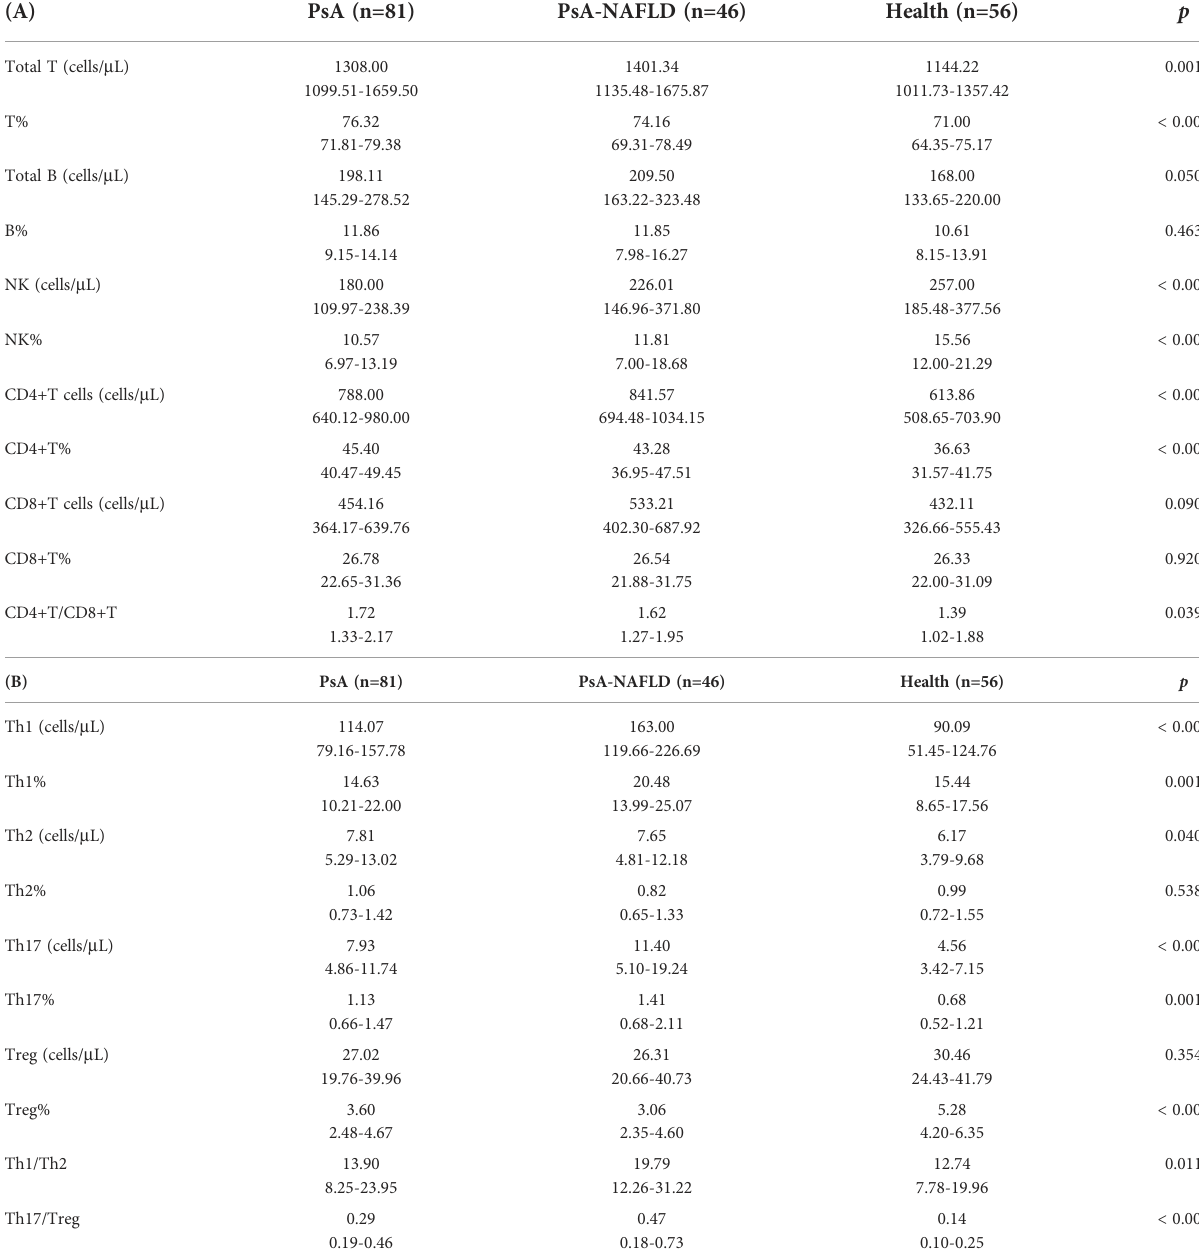
TABLE 2 Absolute counts and proportions of lymphocytes in the peripheral blood in the study